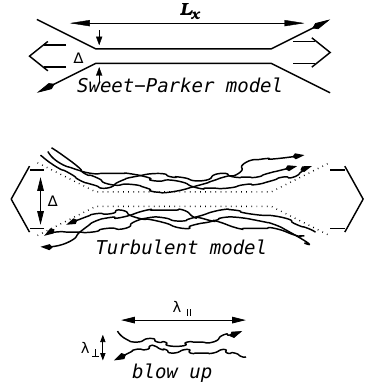
Fig. 3. Upper plot: Sweet-Parker model of reconnection (Sweet, Fig. 3. Upper plot : Sweet-Parker model of reconnection (Sweet, 1958; Parker, 1957). The outflow region is limited within a thin 1958; Parker, 1957). The outflow region is limited within a thin transition zone 1 between the reversed magnetic field lines, which transition zone ∆ between the reversed magnetic field lines, which depends on plasma resistivity. The other scale is an astrophysi- depends on plasma resistivity. The other scale is an astrophysi- cal scale L (cid:29) 1 . Middle plot: reconnection of weakly stochastic cal scale L ≫ ∆ . Middle plot : Reconnection of weakly stochastic magnetic field according to Lazarian and Vishniac (1999). The out- magnetic field according to Lazarian and Vishniac (1999). The out- flow region is determined by the diffusion of magnetic field lines, flow region is determined by the diffusion of magnetic field lines, which depends on the field stochasticity. Lower plot: an individ- which depends on the field stochasticity. Lower plot : An individ- ual small scale reconnection region. The reconnection over small ual small scale reconnection region. The reconnection over small patches of magnetic field determines the local reconnection speed. patches of magnetic field determines the local reconnection speed. The global reconnection speed is substantially larger as many in- The global reconnection speed is substantially larger as many in- dependent patches come together. The bottleneck for the process is dependent patches come together. The bottleneck for the process given by magnetic field wandering and it becomes comparable to is given by magnetic field wandering and it gets comparable to L L as the turbulence injection velocity approaches the Alfvenic one. as the turbulence injection velocity approaches the Alfvenic one. From Lazarian et al. From Lazarian et al. (2004).